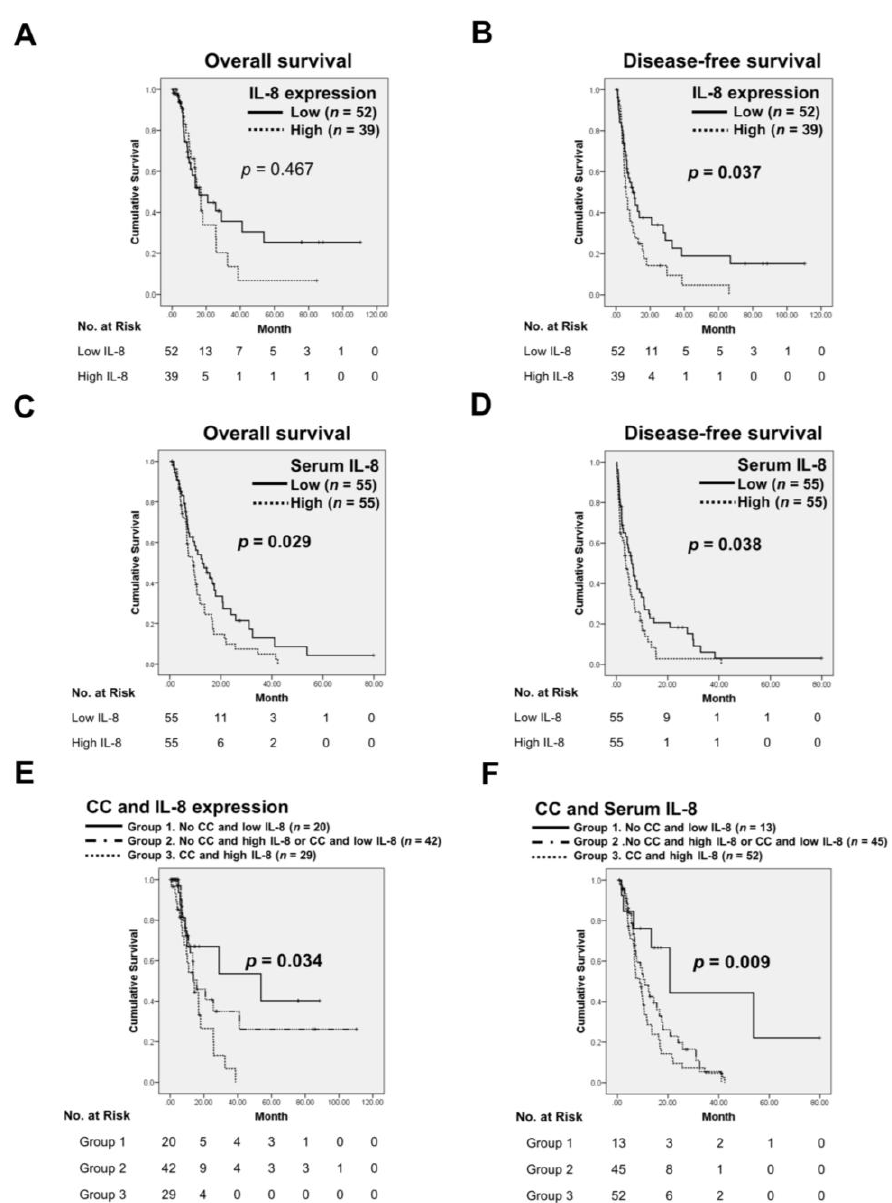
Figure 9. Kaplan–Meier plots for OS and DFS according to the IL-8 expression level in tumor tissues ( A and B ) or serum samples ( C and D ). The co-presence of high IL-8 expression in tumor tissues ( E ) or serum samples ( F ) and CC status had a positive correlation with OS in PC patients by Kaplan–Meier analysis. CC, positive cancer cachexia status; Non-CC, negative cancer cachexia status.